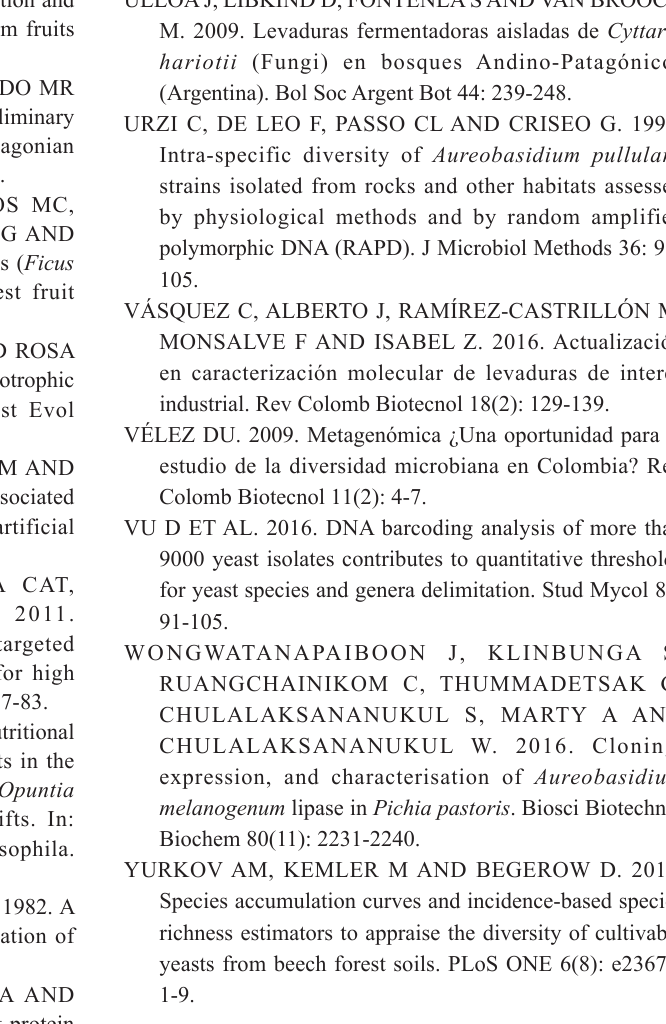
Figure S1 - Phylogeny of yeast species in the Wickerhamomyces clade inferred from the D1/D2 domain of the lSU rRNA gene region. The tree backbone was constructed using Maximum likelihood method. The best substitution model was Tamura- Nei 93 (g+I). Bootstrap percentages over 70% from 1000 bootstrap replicates are shown. Bar = 0.2 substitutions per nucleotide position. Figure S2 - Phylogeny of yeast species in the Pichia clade inferred from the ITS region. The tree backbone was constructed using Maximum likelihood method. The best substitution model was Kimura-2-Parameter (g+I). Bootstrap percentages over 70% from 1000 bootstrap replicates are shown. Bar = 2 substitutions per nucleotide